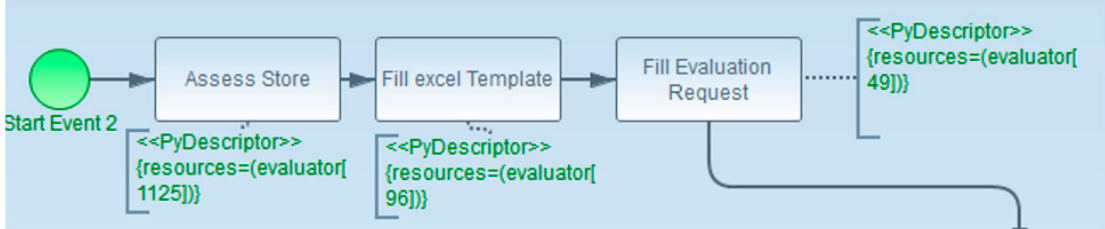
Figure 15. Tasks associated with non-functional measurements. 538